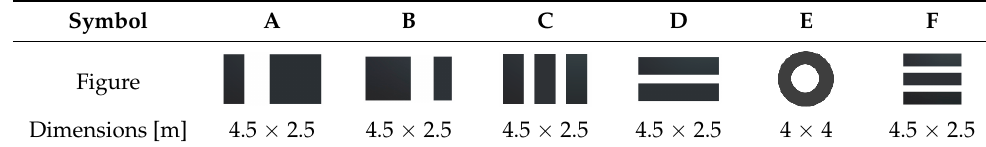
Table 3. VES-PVAS configuration of the third test.